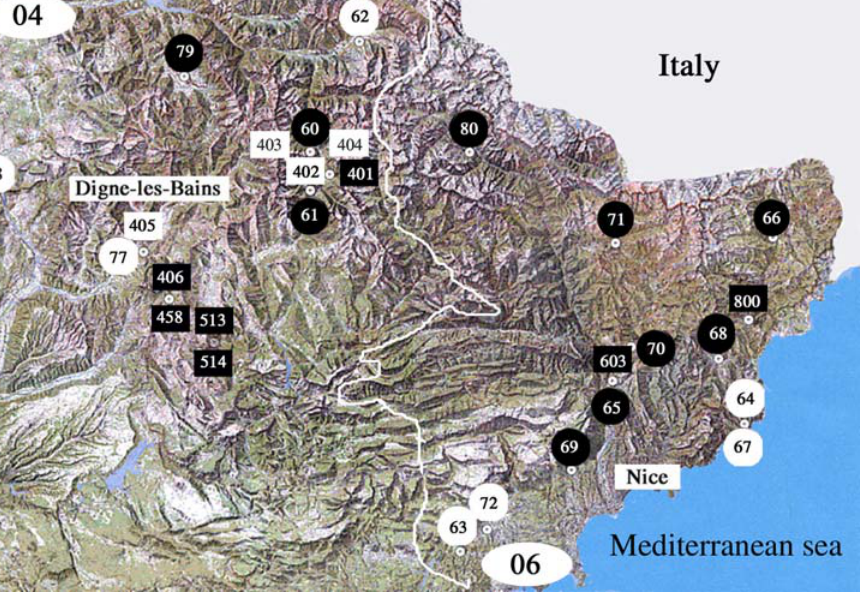
Figure 14. Snake venom characteristics and type of grade 2 and 3 envenomations observed in Alpes-de-Haute-Provence (code no. 04) and Alpes-Maritimes (code no. 06). Envenomation cases are presented in circles and snake venoms in rectangles. Classical venoms or envenomations cases are in white and neurotoxic venoms and envenomations are reported in black. The white line indicates the border between the two deparments.